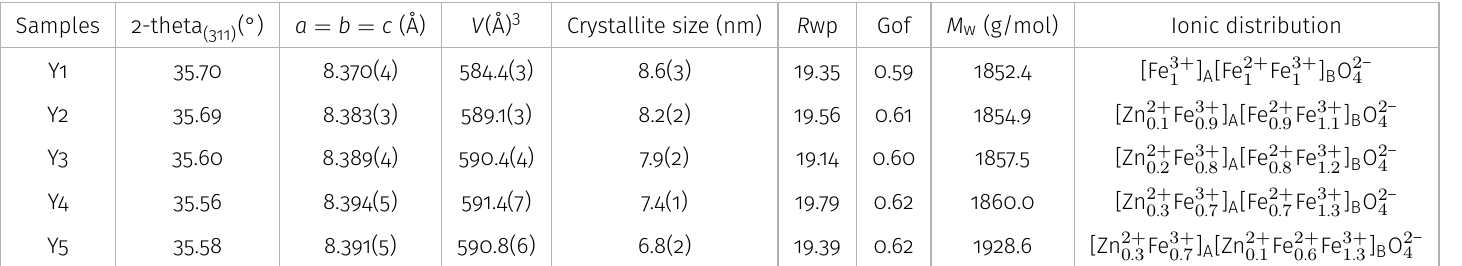
Table I. XRD data analysis results of the Zn-doped magnetite nanoparticles.